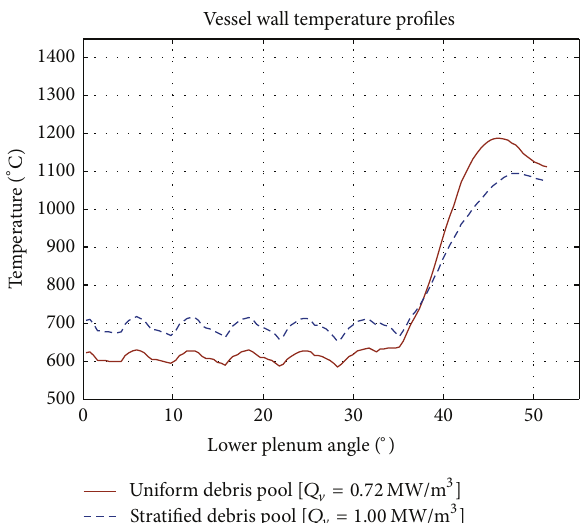
Figure 20: Temperature profiles of the vessel external surface.